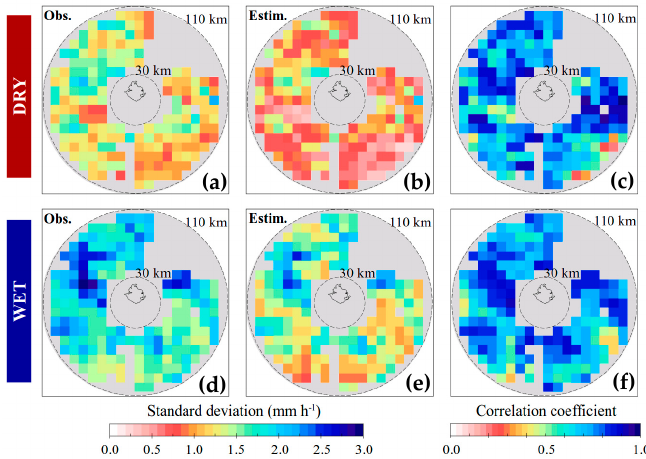
Figure 7. Spatial distributions of the standard deviation of ( a , d ) observed and ( b , e ) estimated errors and their ( c , f ) correlation coefficients over the dry (upper) and wet (lower) seasons.